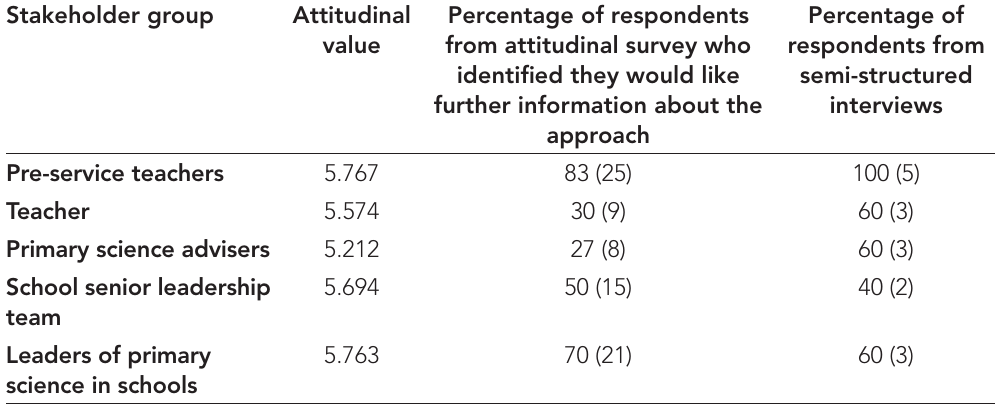
table 5: a comparison of attitudes to a global learning approach to primary science and the desire to pursue further related professional learning (Source: author, 2020) Stakeholder